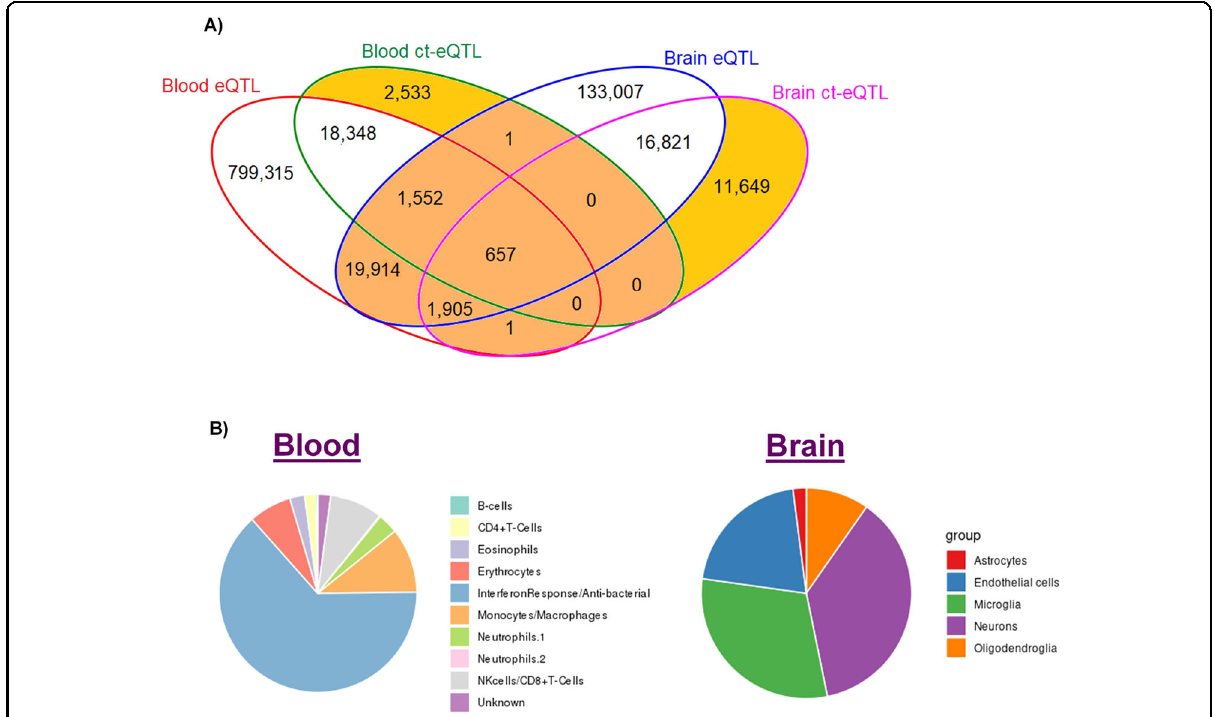
Fig. 1 Signi fi cant gene-SNP eQTLs and ct-eQTLs in blood and brain tissue genome-wide. A Venn diagram shows the number of overlapping eQTLs and ct-eQTLs in blood and brain. Gold color indicates signi fi cant eQTLs that are cell-type-speci fi c. Orange color indicates signi fi cant eQTLs that are shared between blood and brain. B Cell-type distributions of signi fi cant genome-wide ct-eQTL results in blood and